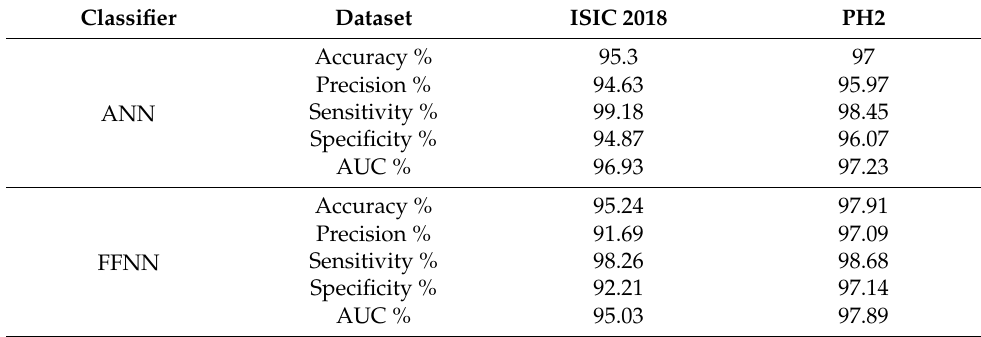
Figure 16. Confusion matrix for the ANN algorithm of the PH2 dataset. Table 4. The performance of the ANN and FFNN algorithms on the ISIC 2018 and PH2